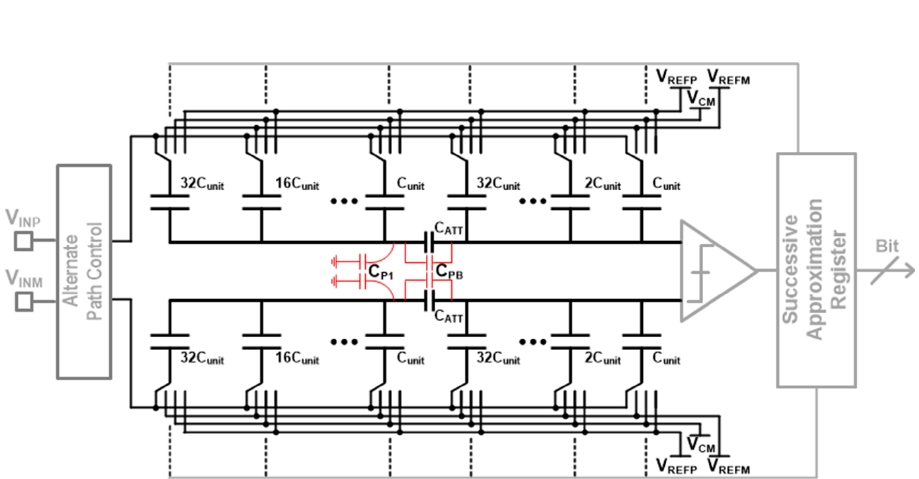
Figure 6. Binary weighted split capacitive digital-to-analog converters (C-DACs).